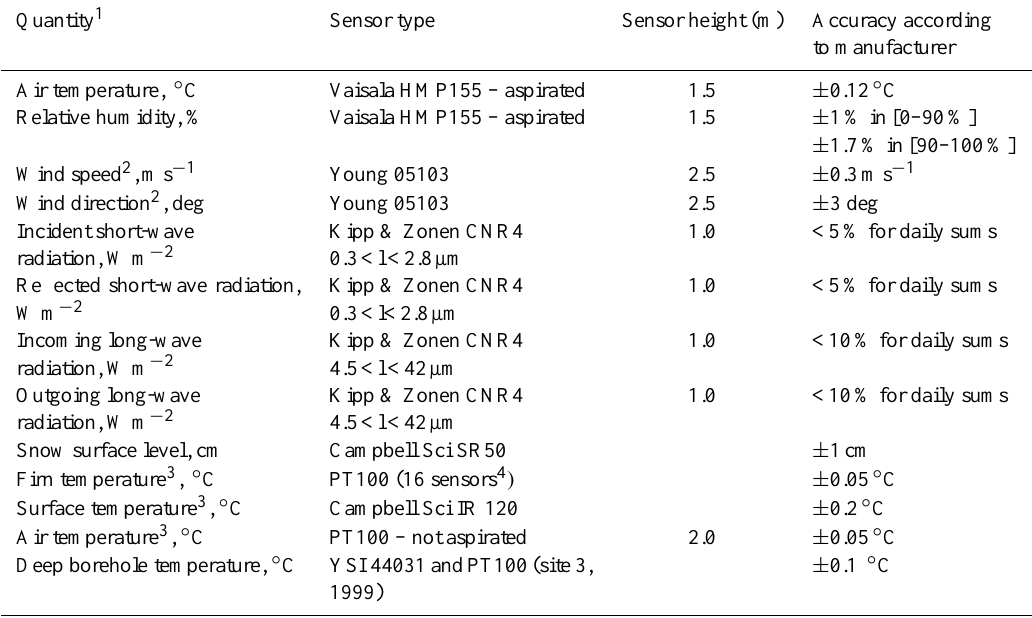
Table 1. List of different sensors of AWS with their